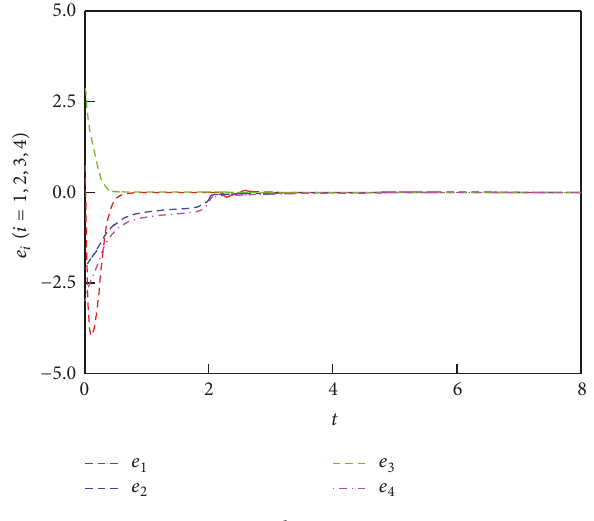
Figure 9: Synchronization